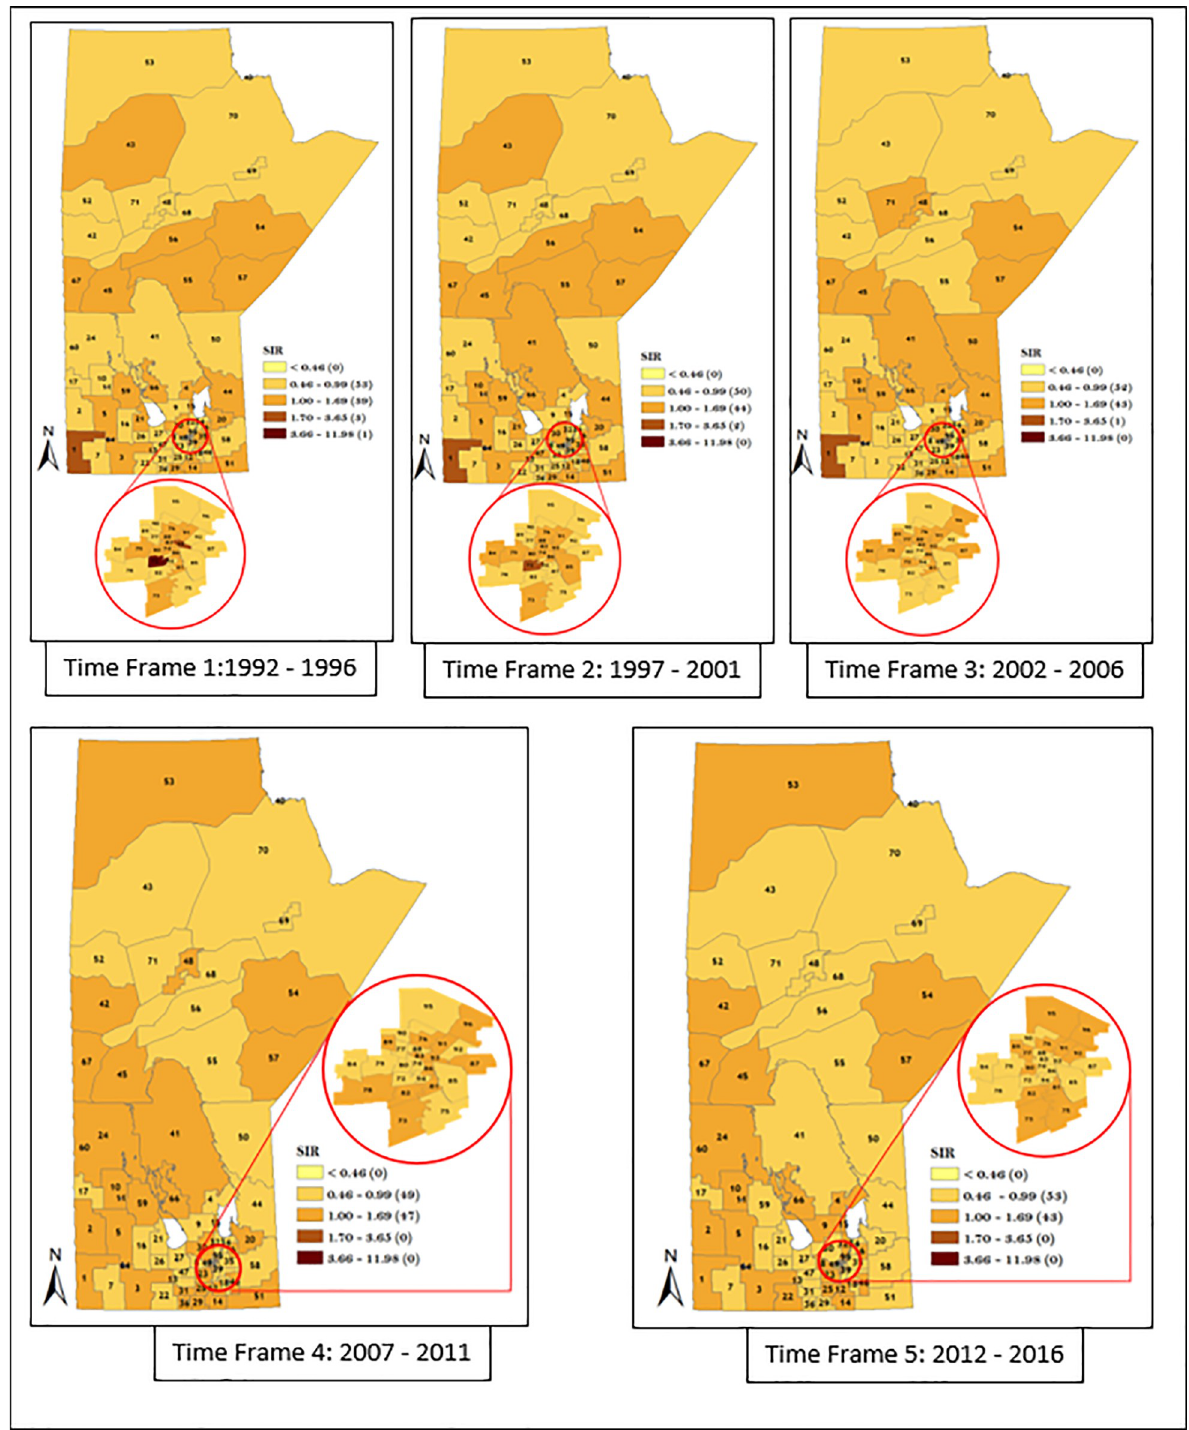
Fig 12. Maps of district-specific risk of overall women GC for 96 RHADs in Manitoba for five time periods, using spatio-temporal Poisson regression model. Numbers in the map are the district labels from 1 to 96. Number of districts in each risk category is shown in parenthesis in the